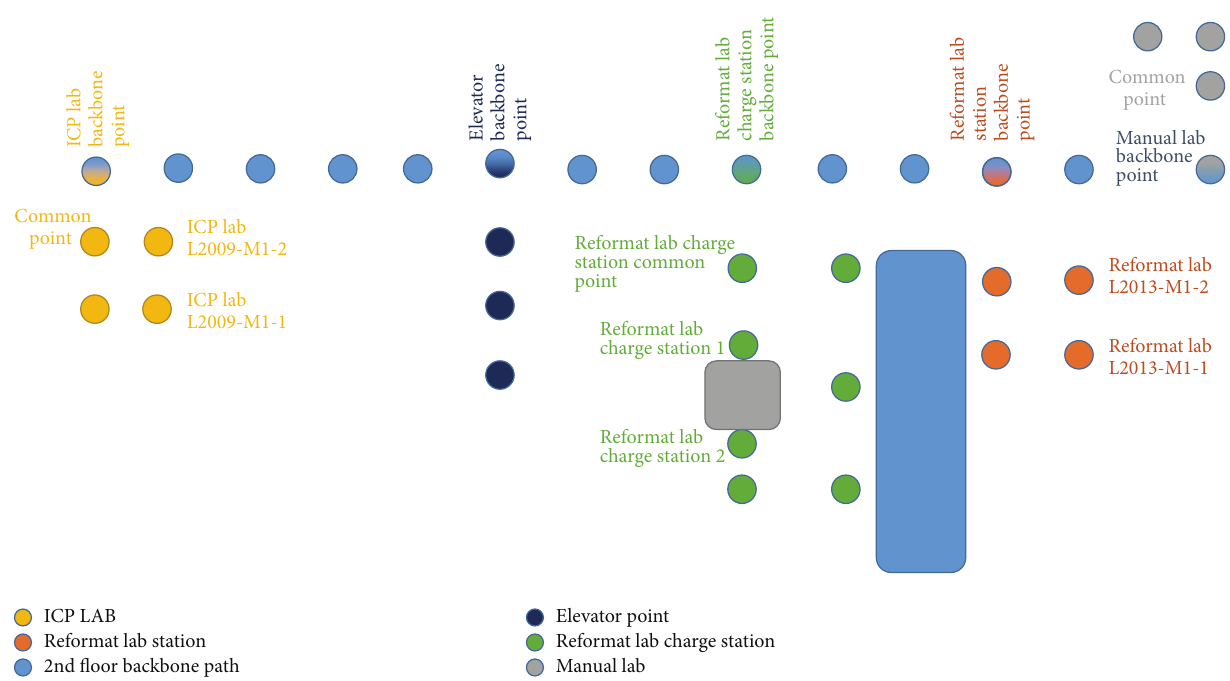
Figure 5: Internal transportation management system.